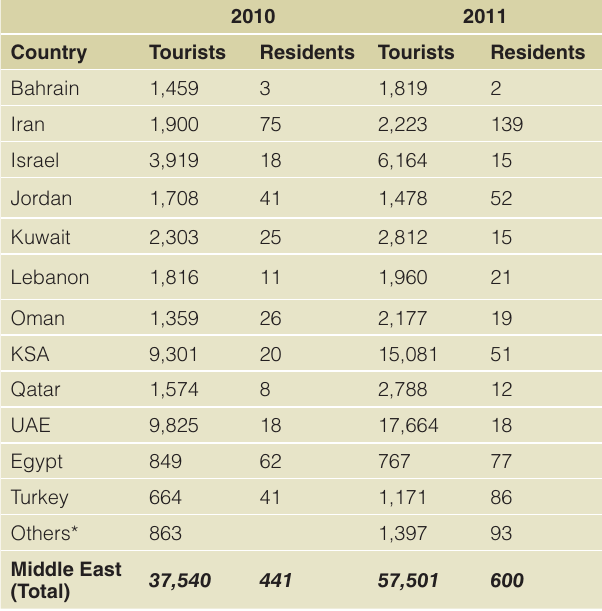
Table 3. Resident visa holders and tourist arrivals from the Middle East in 2010 and